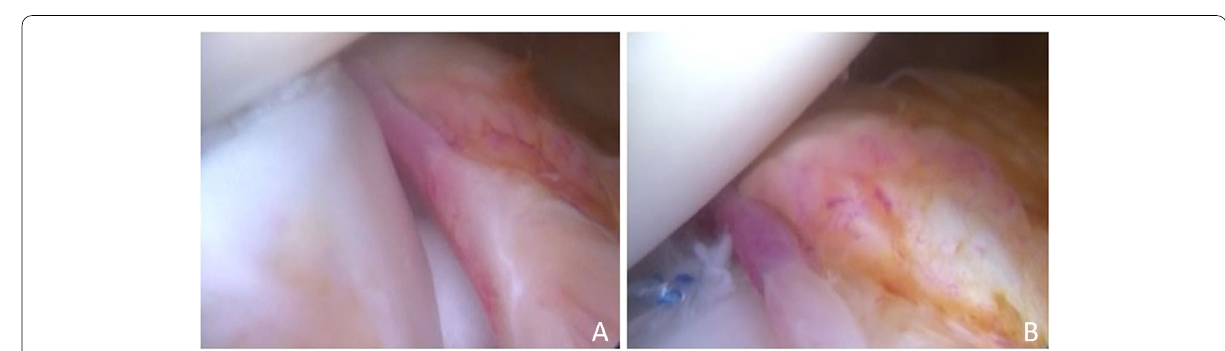
Fig. 3 The ramp lesion, defined as posteromedial meniscocapsular disjunction and visualized with trans-notch view ( A ). The meniscocapsular repair with all-inside technique helps to restore native knee kinematics in concomitant ACL tears ( B